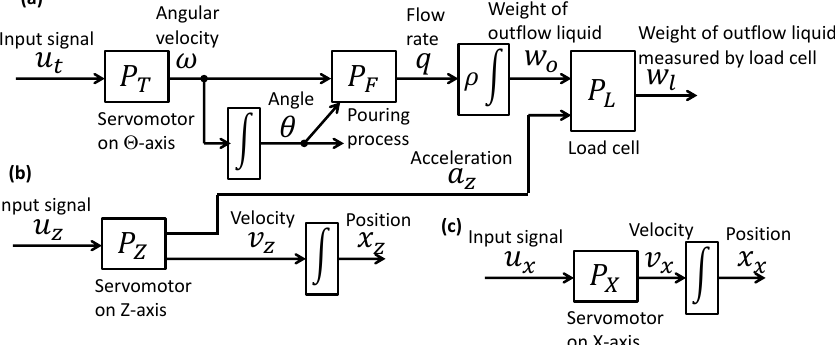
Figure 3. Signal diagram for the tilting-ladle-type automatic pouring machine. ( a ) Drive system of the Θ -axis, with pouring process and load cell; ( b ) drive system of the Z -axis; and ( c ) drive system of the X